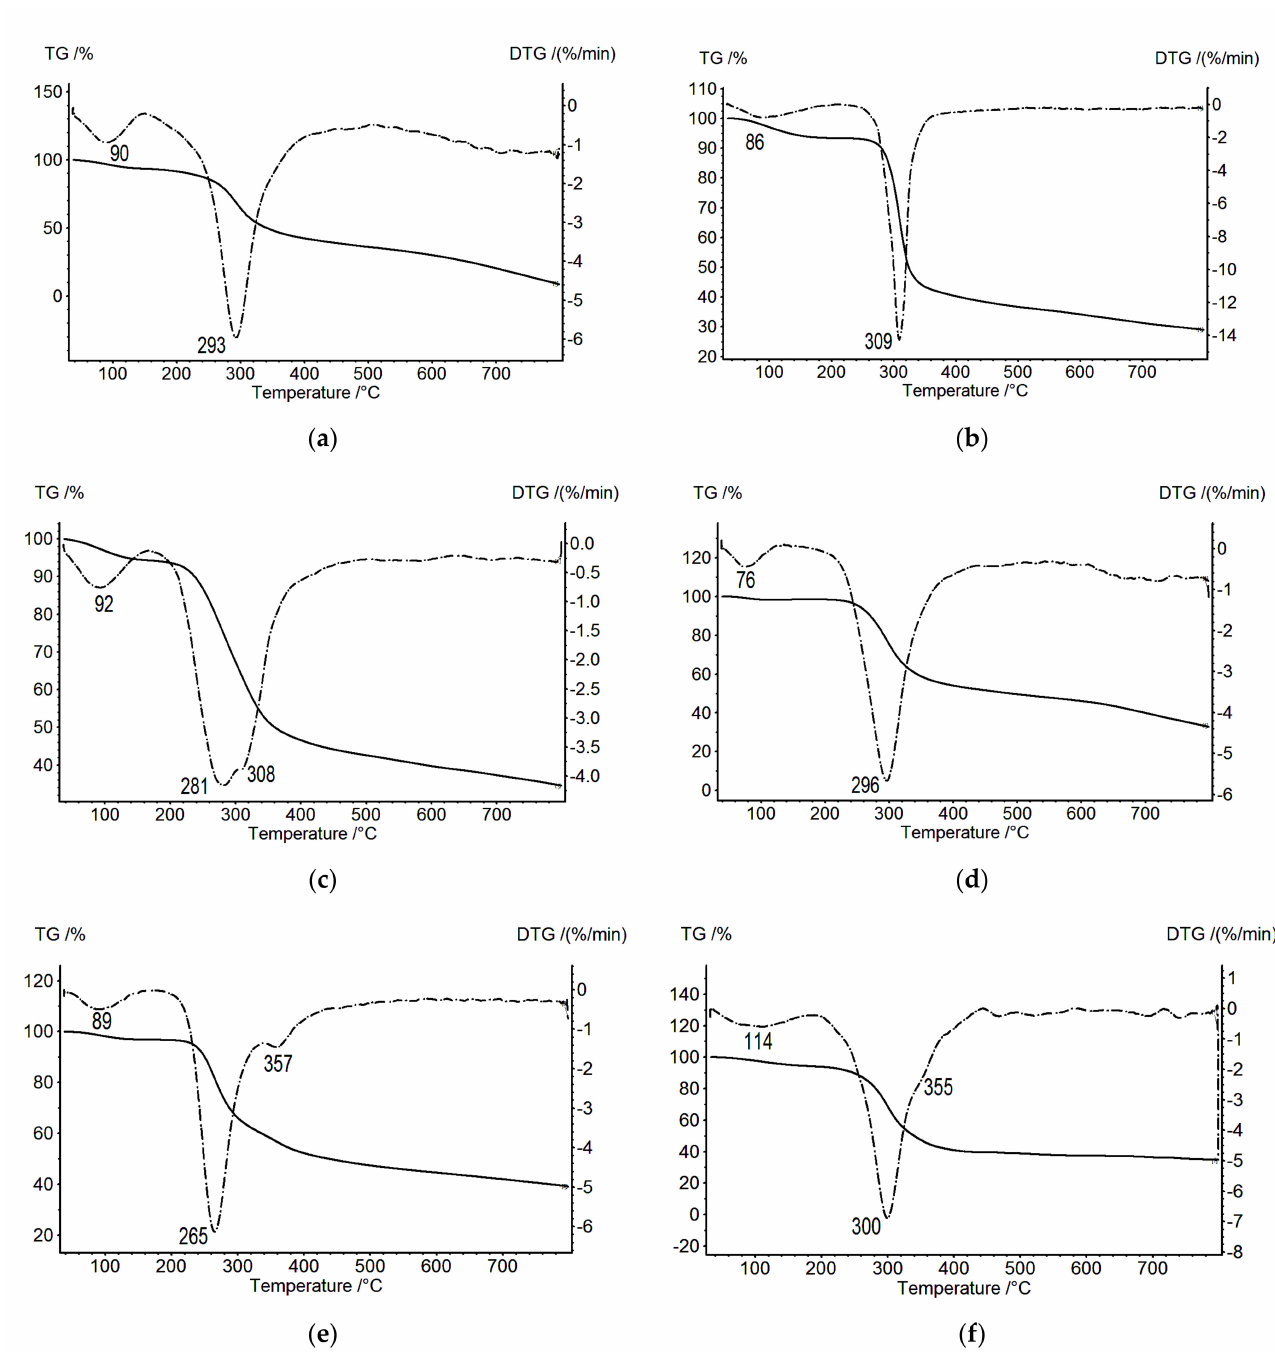
Figure 1. Thermogravimetric (TG; solid lines) and differential thermogravimetric (DTG; dotted lines) curves: ( a ) CS s , ( b ) SEC, ( c ) CS s –PEC SEC –SEC, ( d ) CS b , ( e ) CS b –PEC SEC , and ( f ) CS b after hydrothermal